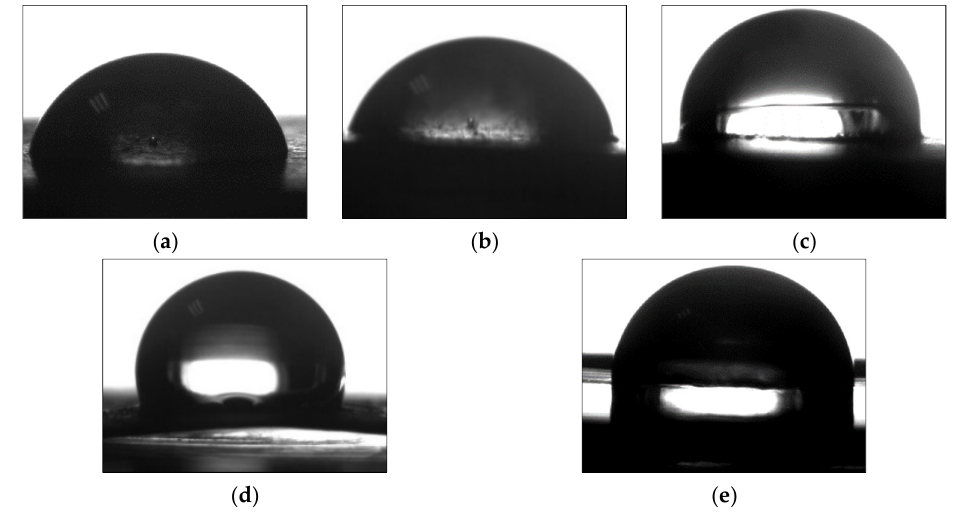
Figure 11. The water contact angles of UV curing films: ( a ) PUA; ( b ) PUA/FCMs-1; ( c ) PUA/FCMs-2; ( d ) PUA/FCMs-3; ( e ) PUA/OCMs.